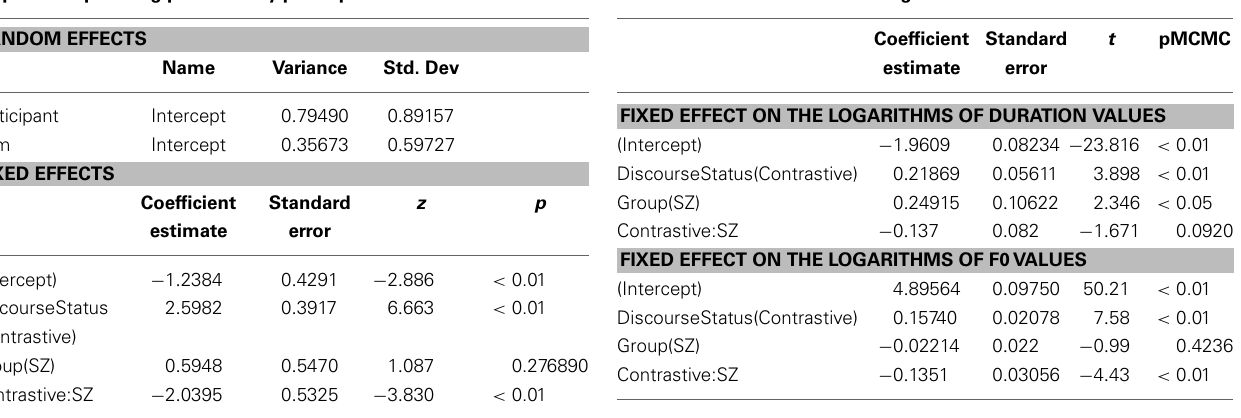
Table 2 | Results of the mixed effects logistic regression fitted on the AP prosodic phrasing produced by participants.